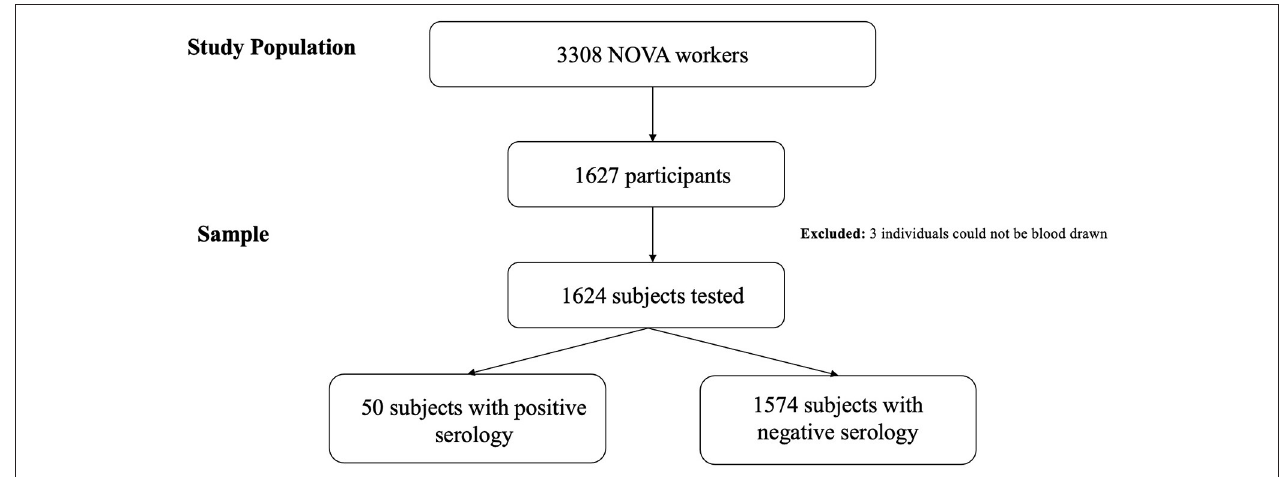
FIGURE 1 | Flowchart of study design to measure SARS-CoV-2 seroprevalence and mental health among NOVA University